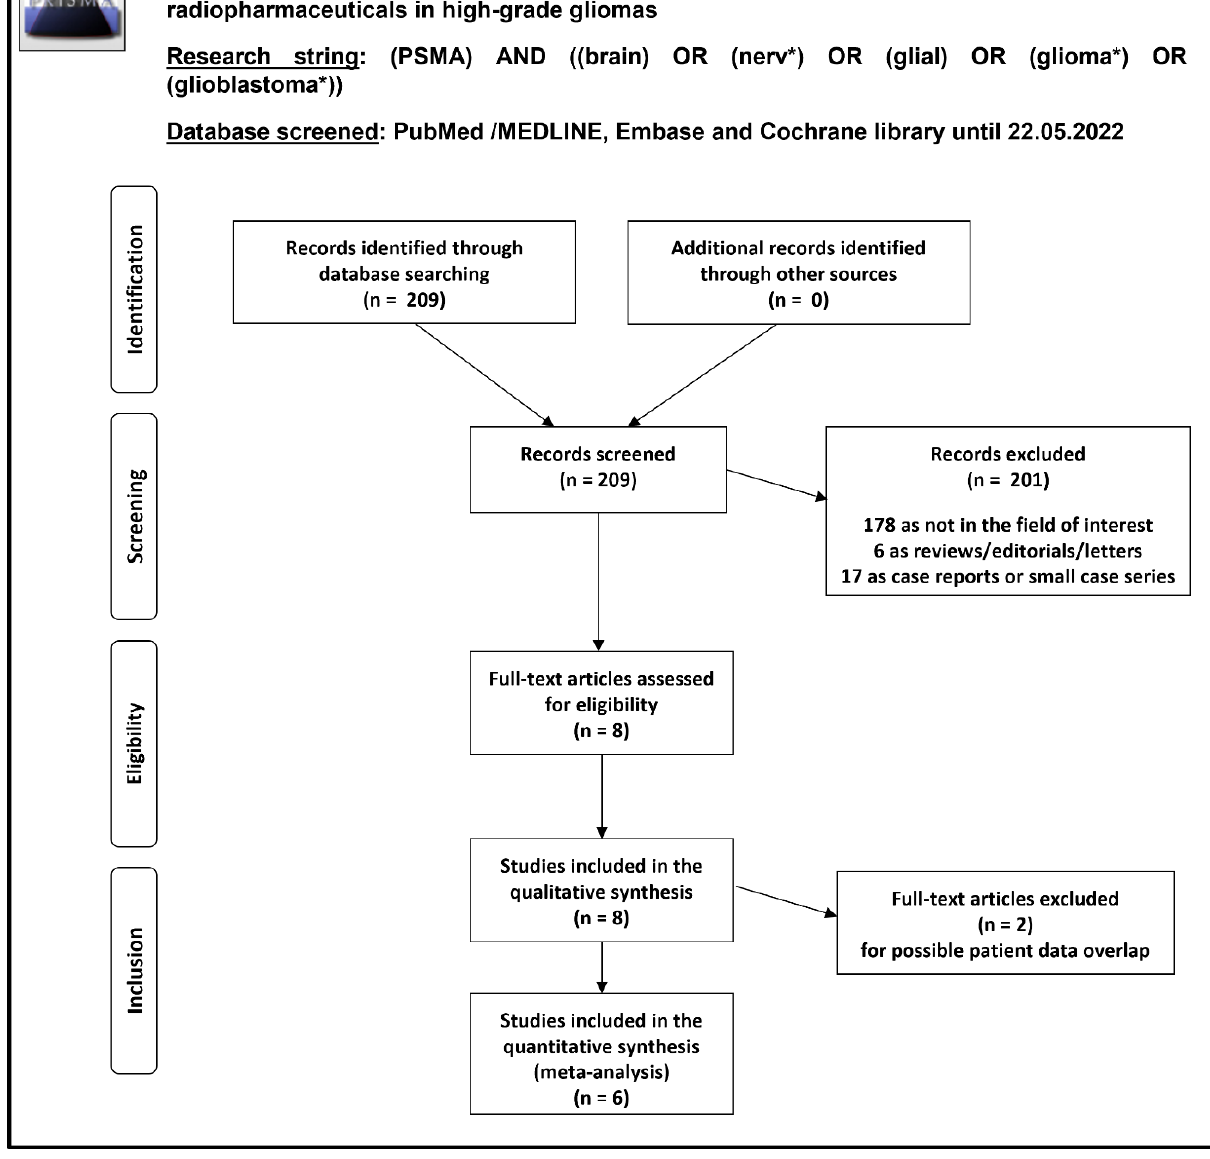
Figure 1. Summary of study selection process for the systematic review and meta-analysis.